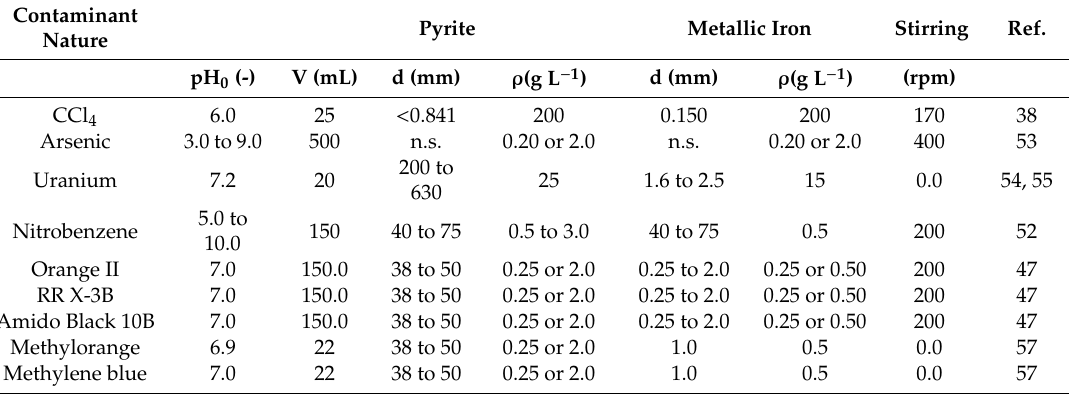
Table 1. Comparison of literature data on experimental conditions for investigating the Fe 0 / FeS 2 / H 2 O system. Studies were performed at initial pH values ranging from 3.0 to 10.0, and Fe 0 mass loadings ranging from 0.2 to 200 g L − 1 . The size of pyrite and Fe 0 also showed large variations among studies. “n.s.” stands for not specified, the authors have referred to Supporting